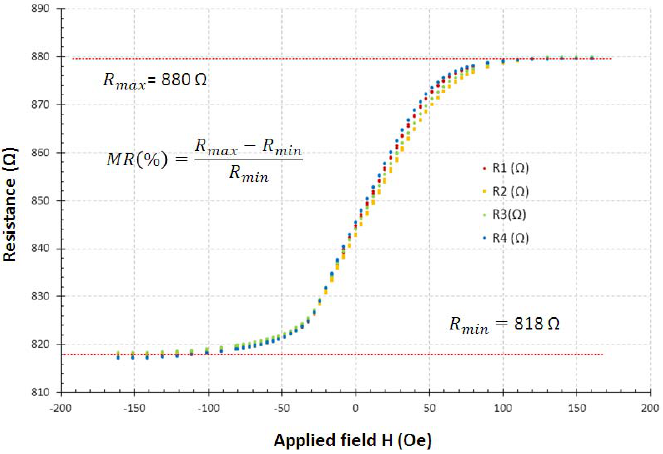
Figure 4. R-H characteristic of the spin valve sensor used in this work (MR = 7%) f